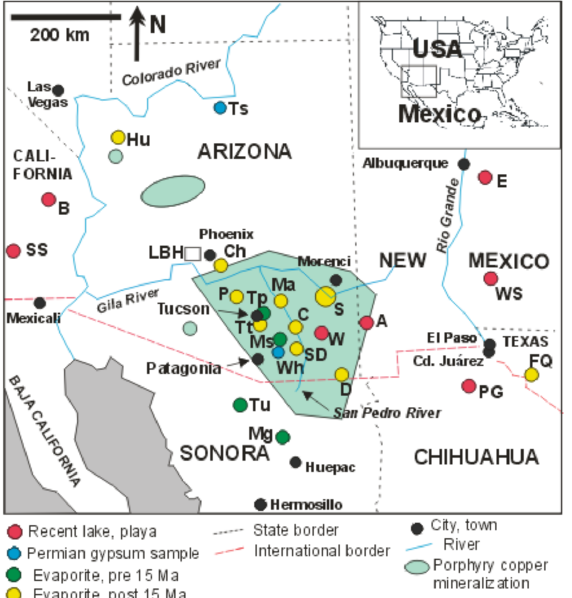
Figure 1. Map of southwest North America, showing locations mentioned in the paper relative to zones of porphyry copper mineralization. A = Animas Playa; B = Bristol Lake; C = Cascabel; Ch = Chandler Basin; D = Douglas; E = Estancia Basin; FQ = Fort Quitman; Hu = Hualapai Basin; LBH = Luke Basin halite; Ma = Mammoth; Mg = Magdalena; Ms = Marsh Station; P = Picacho Basin; PG = Playa Guzman; S = Safford Basin; SD = Saint David; SS = Salton Sea; Tp = Tucson Basin, Pantano Formation; Tt = Tucson Basin, Tinaja Beds; W = Willcox Playa; WS = White Sands dune field; Wh = Whetstone Mountains. Details of sample locations in the Safford and Tucson Basins and at Douglas are given in Supplementary Figures S1–S3.